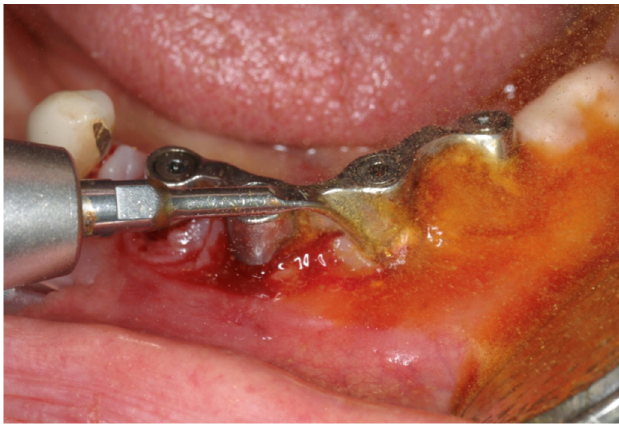
Figure 2. OHLLT surgical approach. Ultrasonic instrumentation for supra- and subgingival scaling with water–betadine irrigation (5:1 ratio).